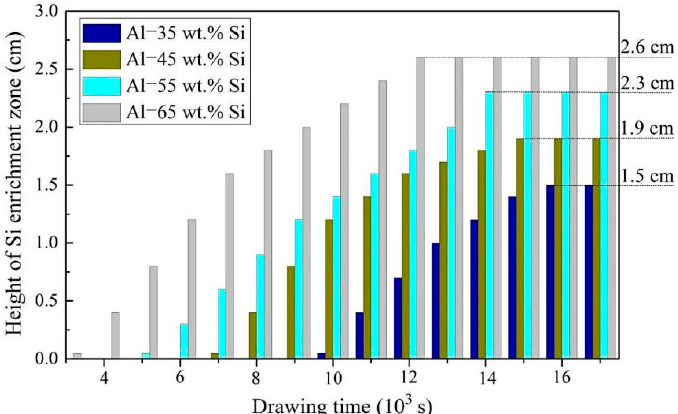
Figure 8. Height change of Si growth interface with the drawing time.